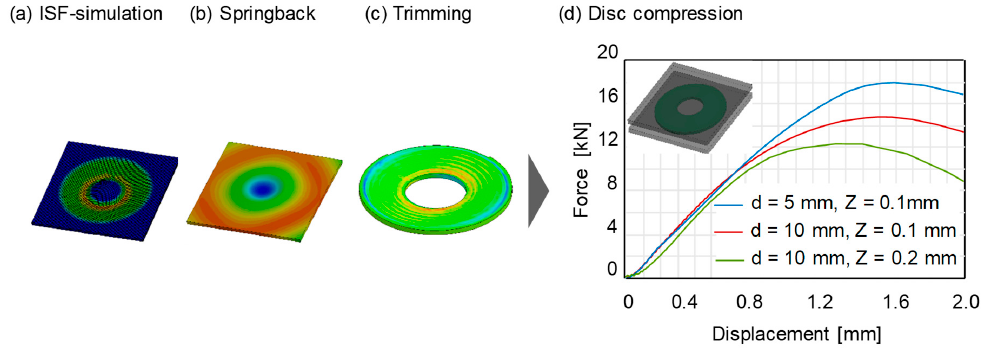
Figure 16. Numerical procedure for the disc compression test under varying process parameters.